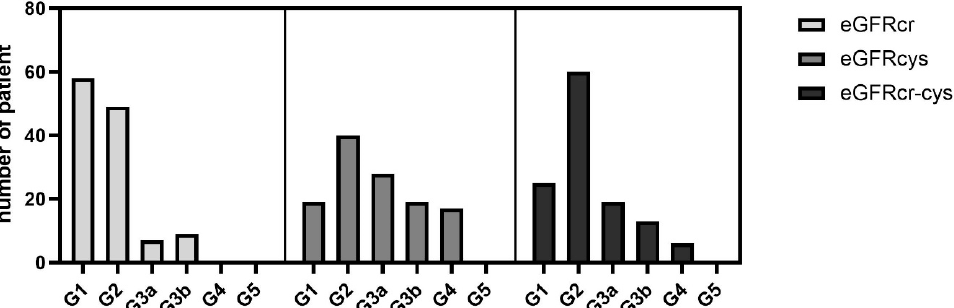
Figure 3. Absolute number of patients divided into the GFR category according to KDIGO. In the one-way ANOVA test, there was no significant difference among means of the three equations p -value =